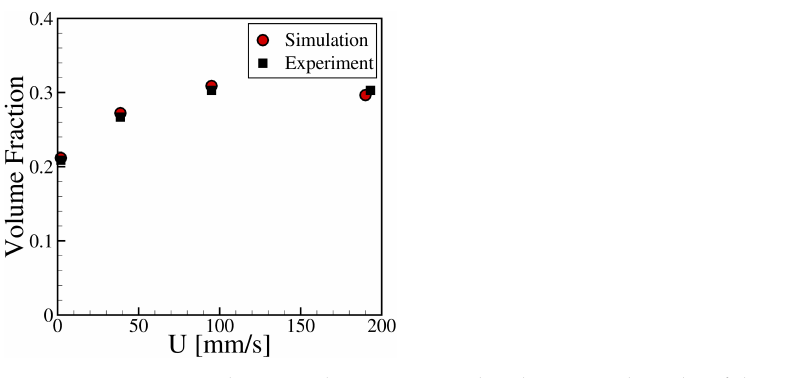
Figure 5. Comparison between the experimental and numerical results of the volume transferred to the substrate at different separation velocities, U, obtained for an aqueous solution of 20 K PEO at 20 wt%. The experimental data were extracted from the work of Sankaran and Rothstein